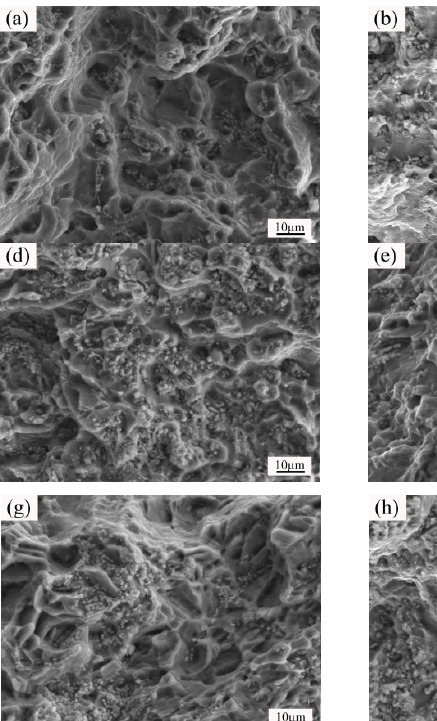
Figure 17. Fracture morphology of isothermal forging parts after post heat treatments: ( a ) 440 °C—1